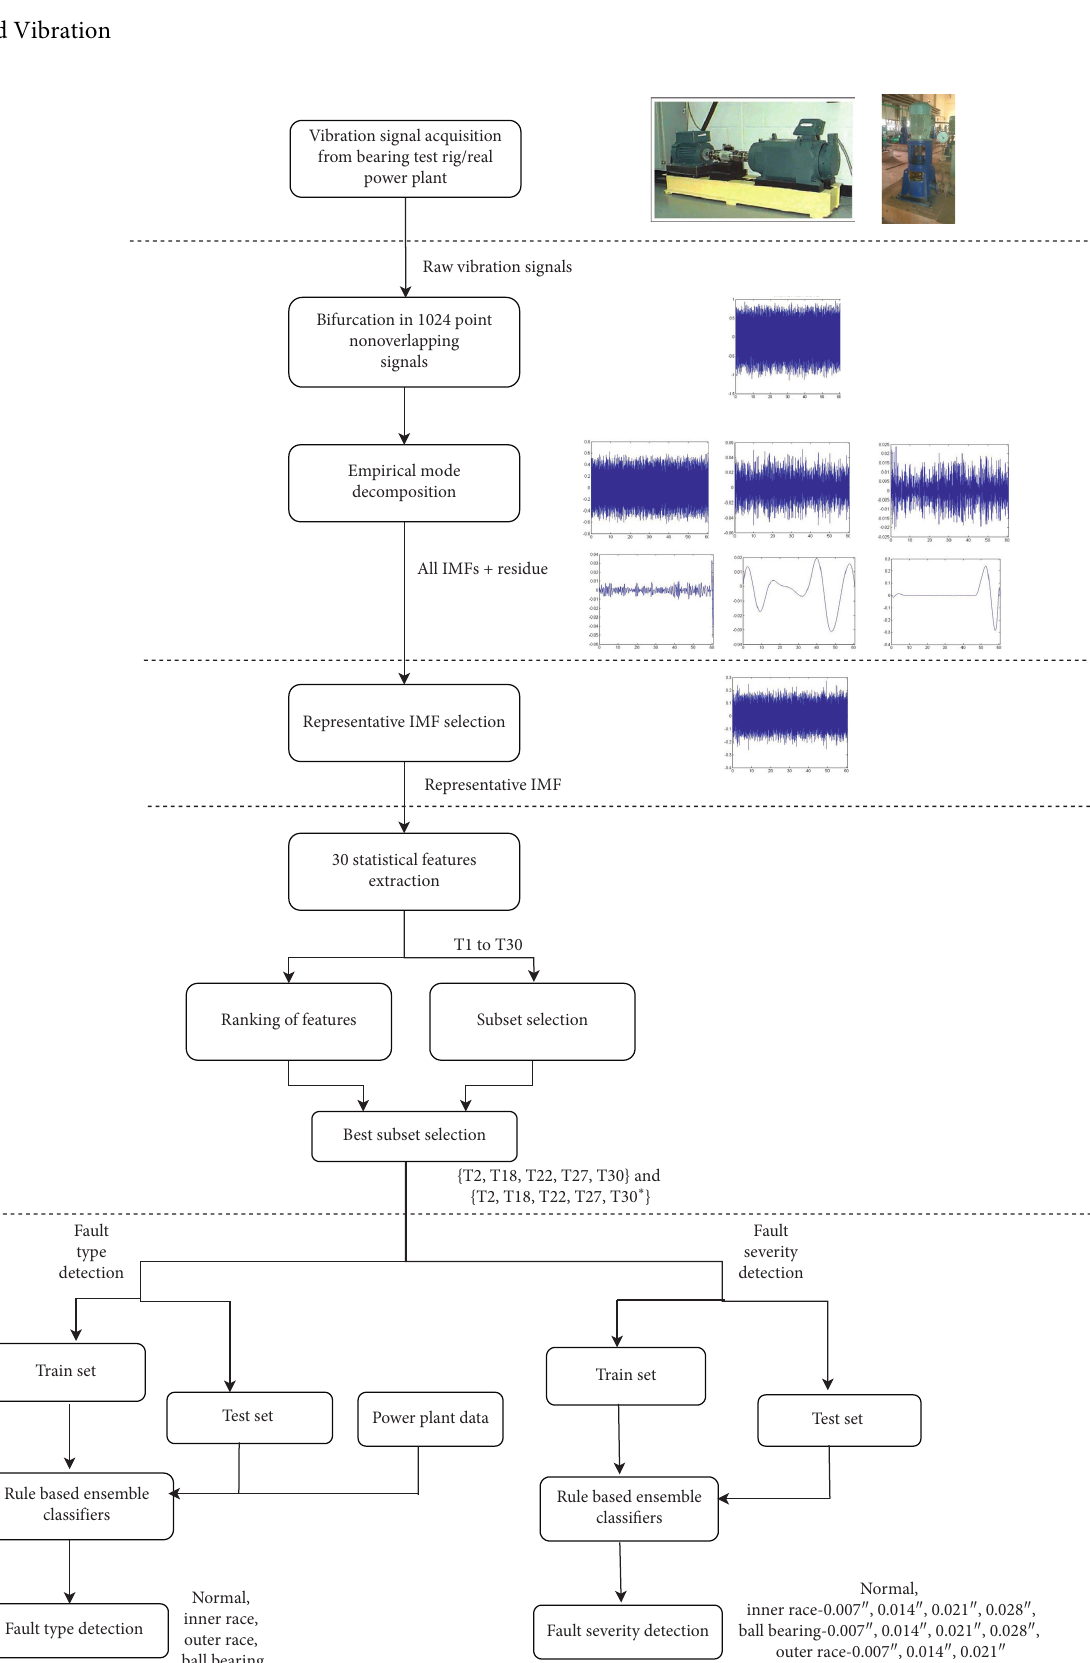
Figure 1: Flowchart of the proposed